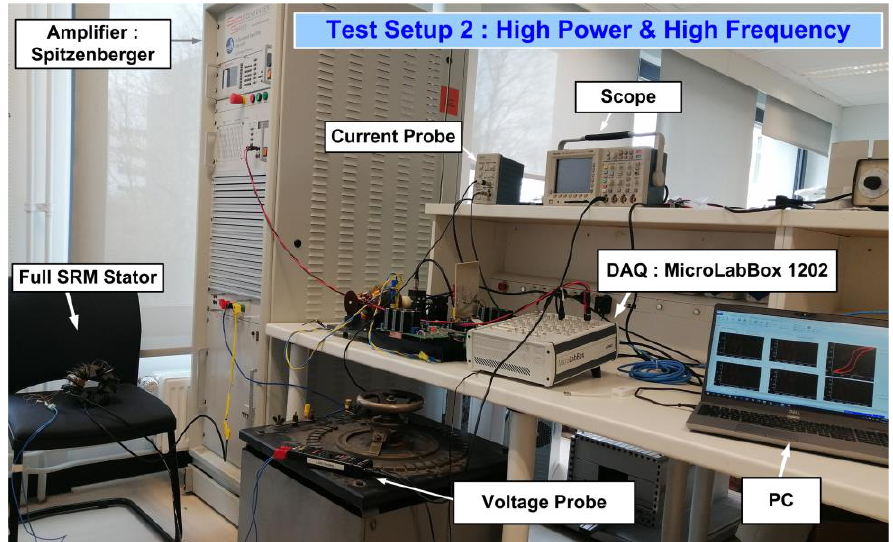
Energies 2022 , 15 , x FOR PEER REVIEW 10 of 18 Figure 7. Experimental setup for a complete stator core of the SRM at high power and high frequency.